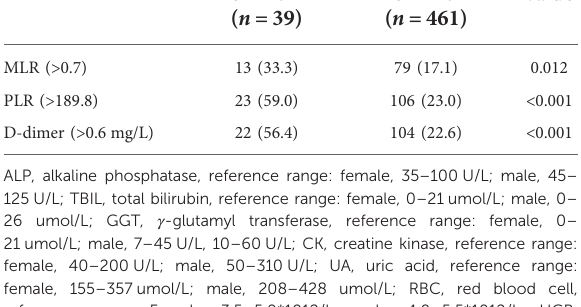
TABLE 3 Multivariate analysis of factors associated with preoperative DVT of patella fractures. Variables OR and 95%